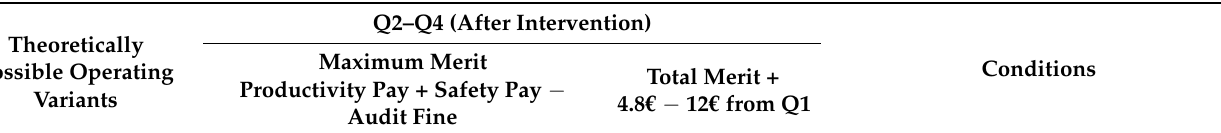
Table 1. Insights into modeling rule-related behaviors and their effects on pay, including consideration of incentive and non-incentive reward